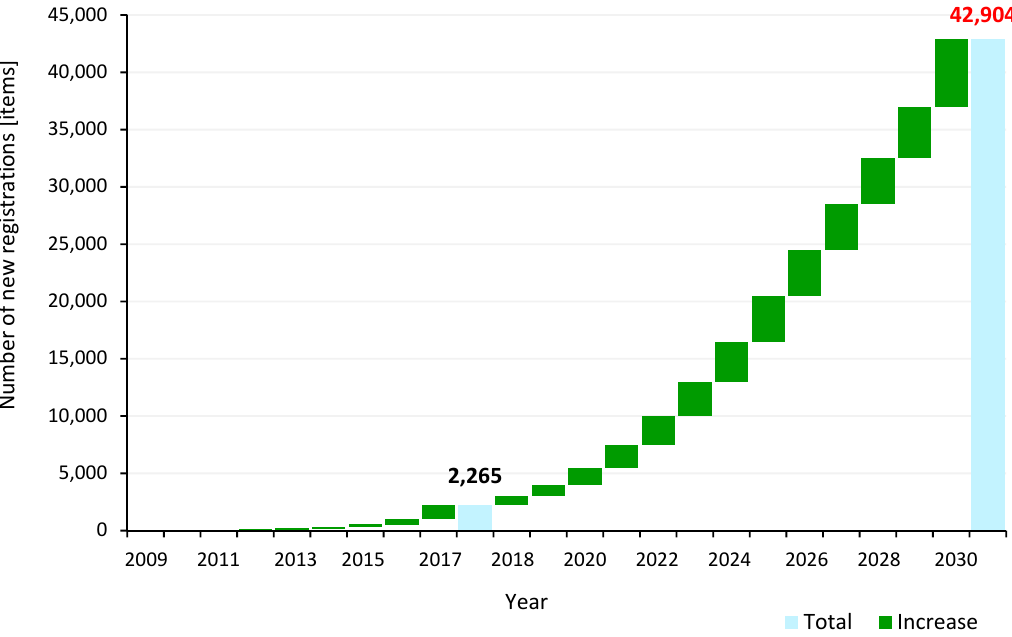
Figure 2. New registrations of electric cars in Poland in 2009–2017 with a forecast until 2030. Compared to other EU countries, there are not very many electric cars registered in Poland.